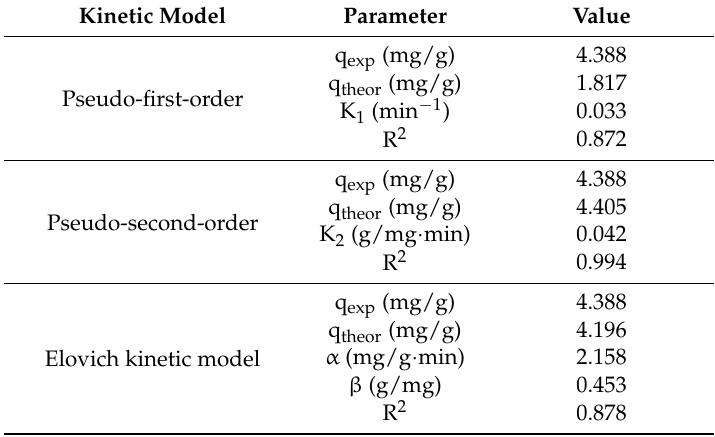
in Table 3. The linearity of ln (q e − q t ) plotting against time indicates that the phenol sorption process